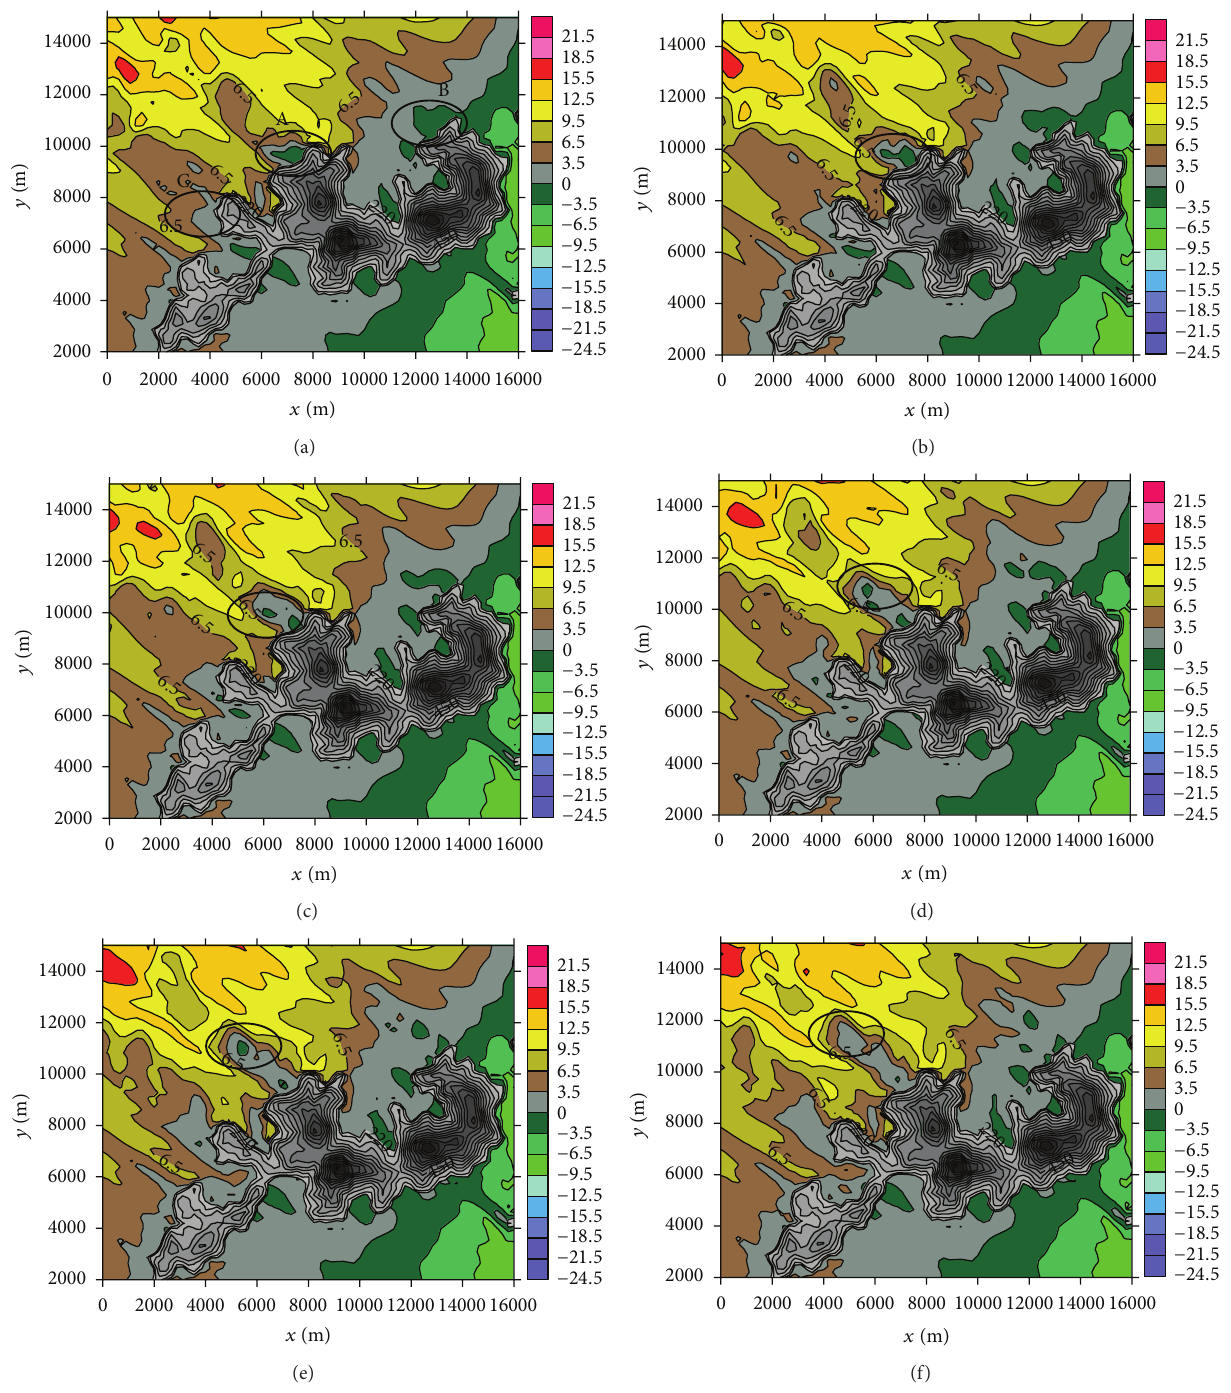
Figure 4: FLUENT simulated radial wind speed at 220m elevation ((a) represents the 27th minute of the simulation period with 1-minute intervals between each figure).